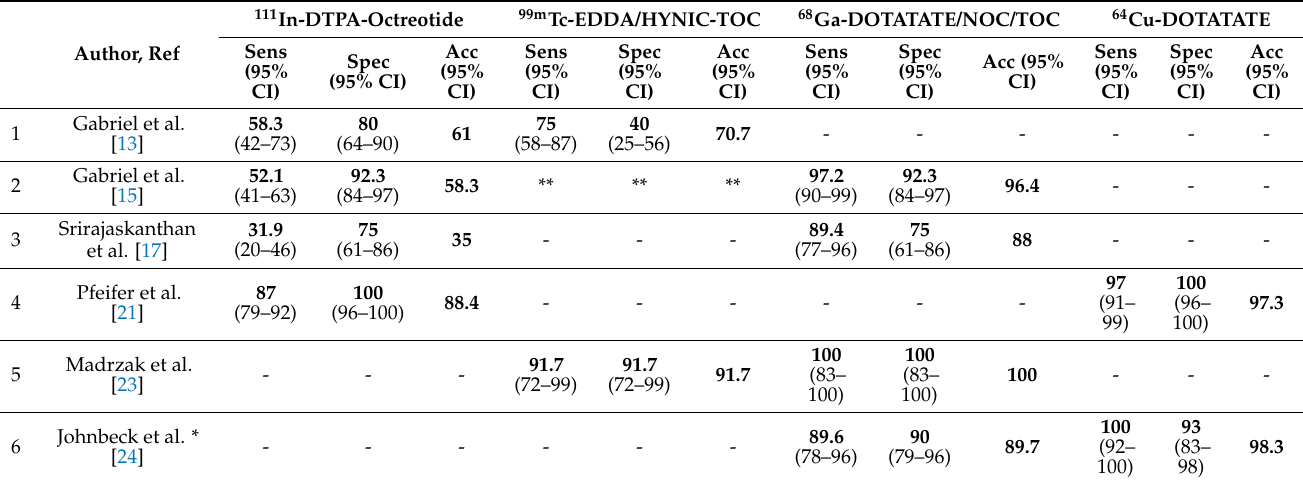
Table 3. Diagnostic accuracies of some selected